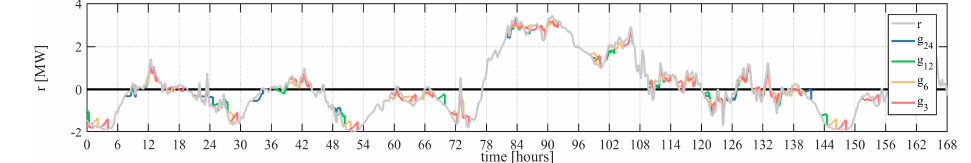
Figure 17. The S energy evolution achieved by OPEM over a generic week at T = 24 h.